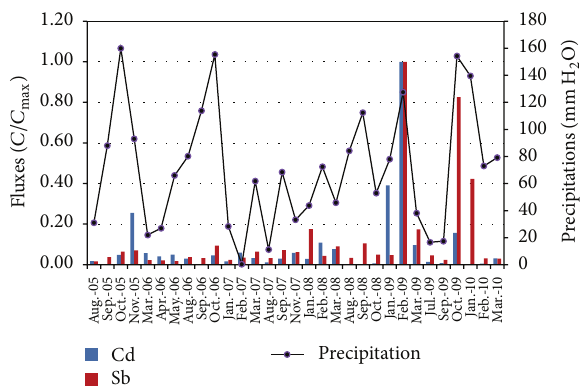
Figure 9: Fluxes of fluoranthene and benzo(a)pyrene and precipi- tations in D4 from August 2005 to March 2010.